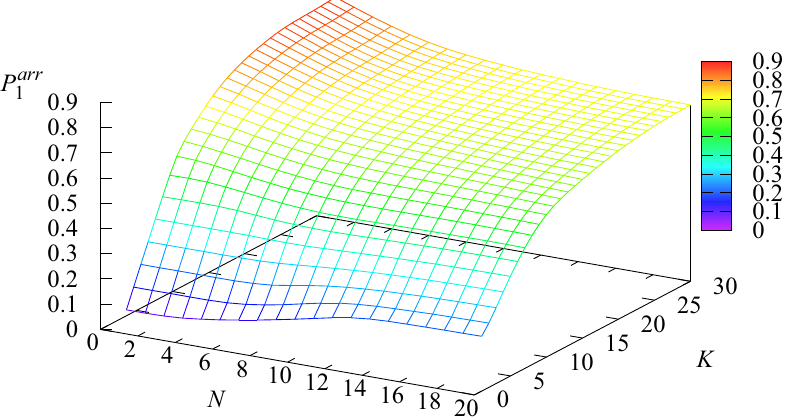
Figure 6. Dependence of the probability P arr the parameters N and K